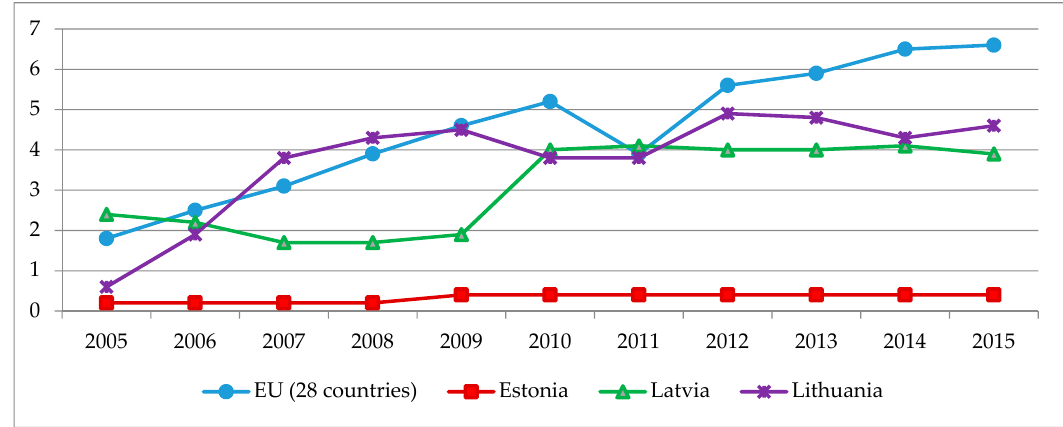
Figure 10. The use of renewable energy in fuel consumption of transport, %.